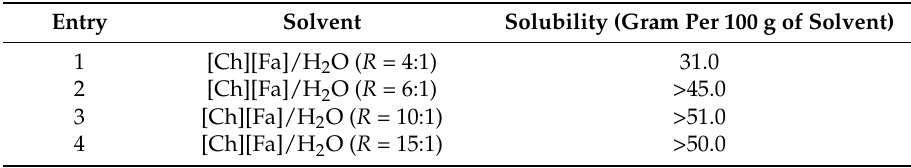
Table 3. Solubility of lignin (enzymatically hydrolyzed) in the [Ch][Fa]/H 2 O solvents at 25 ◦